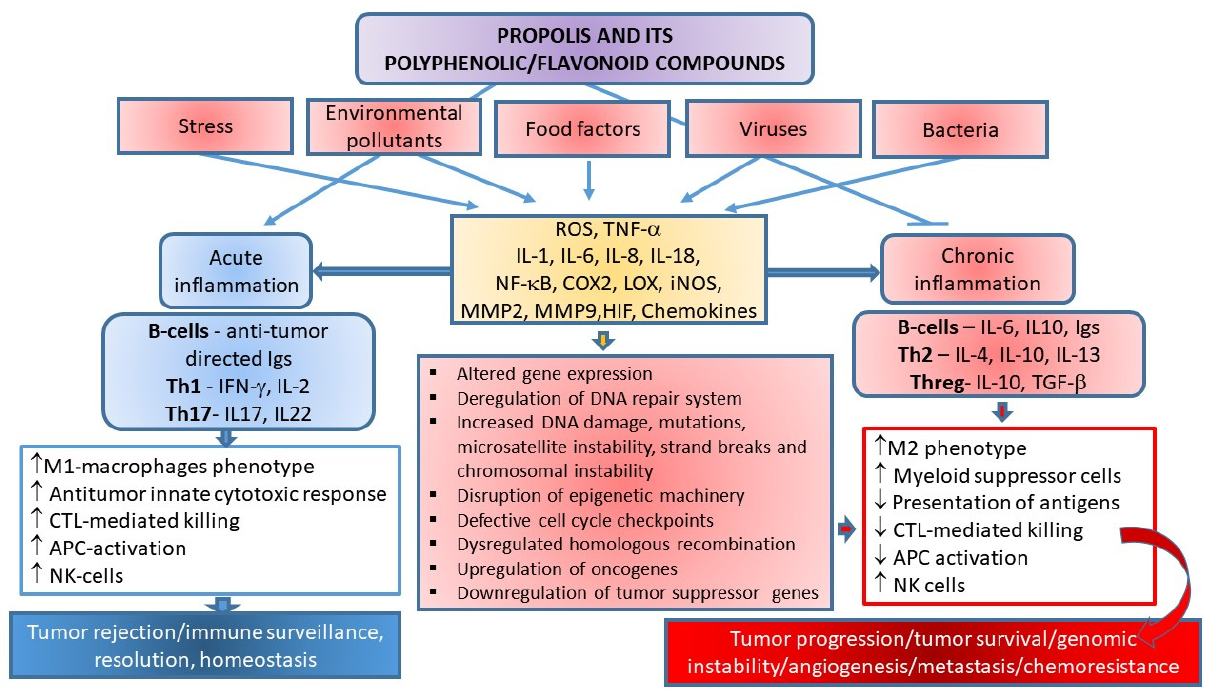
Figure 3. Relationship between ROS, inflammation, cancer, and propolis compounds. Increased oxidative stress can result from numerous endogenous and exogenous factors. An increase in ROS levels and a redox imbalance stimulate intracellular signaling cascades that can potentially stimulate different states of inflammation and their role in tumorigenesis. Under physiological conditions, phagocyte-derived oxidants have a protective function by disabling invading bacteria and parasites, destroying the damaged cells. Controlled, physiological inflammation is a useful, adaptive response that plays an important role in protection against infection, tissue repair, and adaptation to stress, more exactly, in the establishment of disturbed homeostasis. Chronic inflammation is linked to various steps of tumorigenesis, including cellular transformation, progression, survival, proliferation, invasion, angiogenesis, and metastasis. Propolis and its components scavenge reactive oxygen intermediates or prevent their formation, and thus reduce DNA damage, mutagenesis, and the transformation of normal cells into tumor ones. In addition, natural ingredients of propolis induce a prominent reduction in CD4 + CD25 + FoxP3+ regulatory T cells that suppress antitumor activity by IL-10 or TGF- β production. Inhibition of the M2 phenotype and stimulation of the M1 macrophage polarization associated with the production of Th1 cytokines such as TNF- α , IFN- γ , and colony-stimulating factor 2 (CSF2), increase antigen-presenting capacity, as well as the production of ROS and cytokines (IL-6, IL-12, IL-23, and TNF- α ) that both contribute to the microbicidal and pro-inflammatory activities of M1 macrophages, which are termed as “fighting” macrophages. M1 macrophages are associated with a good prognosis in the cancer context. Note: ROS, Reactive oxygen species; TNF- α , Tumor necrosis factor-alpha; IL, Interleukin; NF- κ B, Nuclear factor kappa-light- chain-enhancer of activated B cells; COX-2, Cyclooxygenase-2; LOX, Lipoxygenase; iNOS, Inducible nitric oxide synthase; MMP2, Matrix metalloproteinase2; MMP9, Matrix metalloproteinase 9; HIF, Hypoxia-inducible factor; Th1, T helper 1 cells; Th2, T helper 2 cells; Th17, T helper 17 cells; Threg, Regulatory T cells; TGF- β , Transforming growth factor β ; Igs, Immunoglobulins; CTL, Cytotoxic T lymphocytes; APC, Antigen-presenting cell; NK, Natural killer cell.